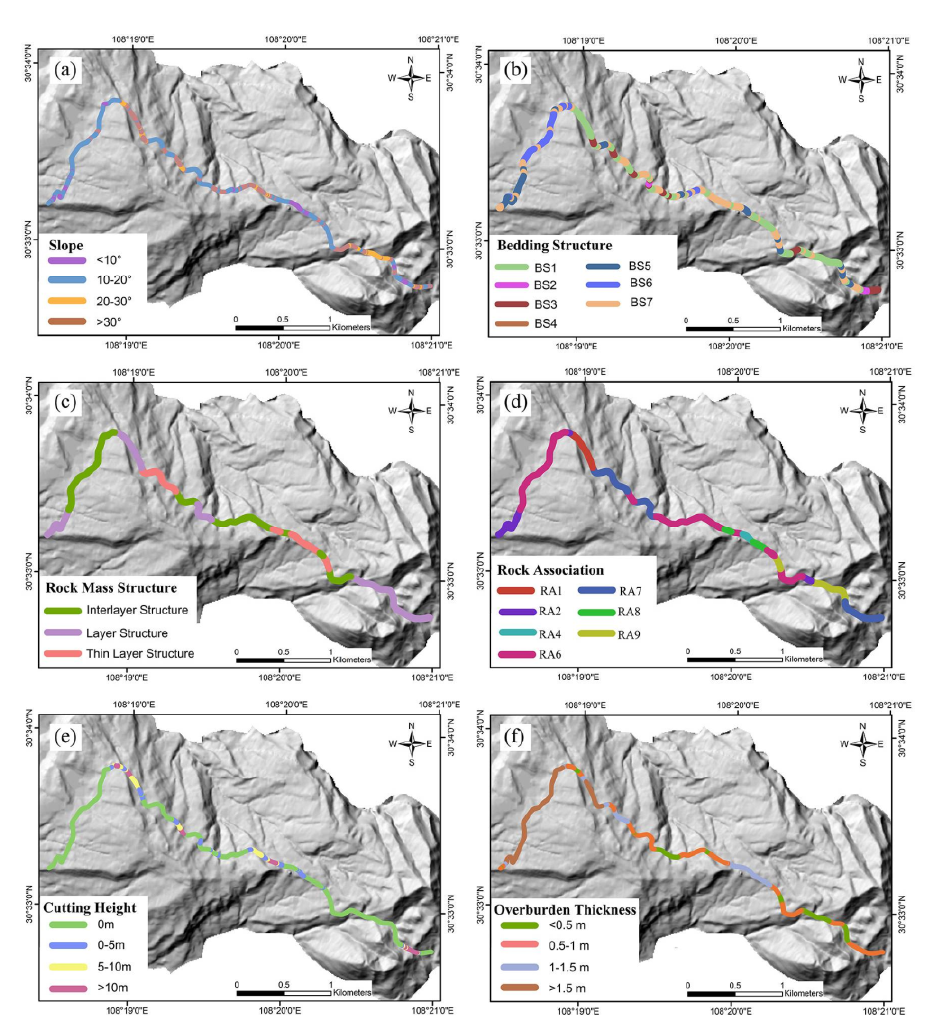
Figure 5. Landslide causal factors of the road affected area: ( a ) slope, ( b ) bedding structure, ( c ) rock mass structure, ( d ) rock association, ( e ) cutting height, ( f ) overburden